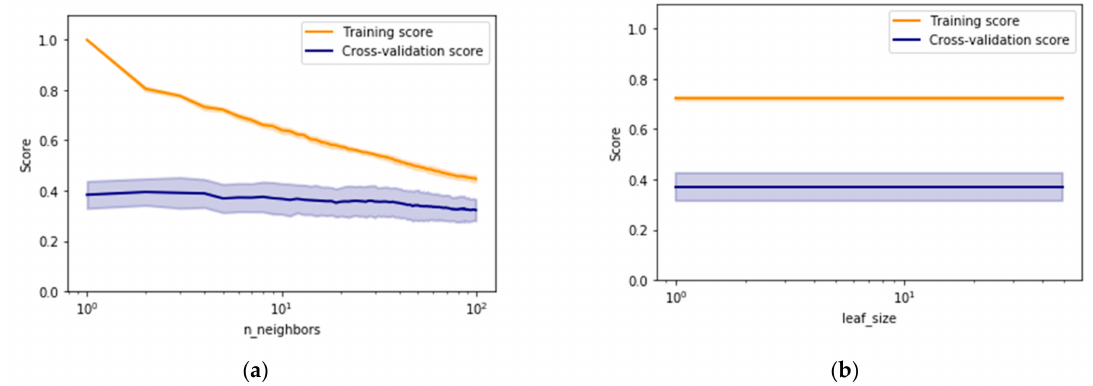
Figure 8. Validation curves generated for the important parameters of KNC classifier ( a ) Number of neighbors ( b ) Leaf size.